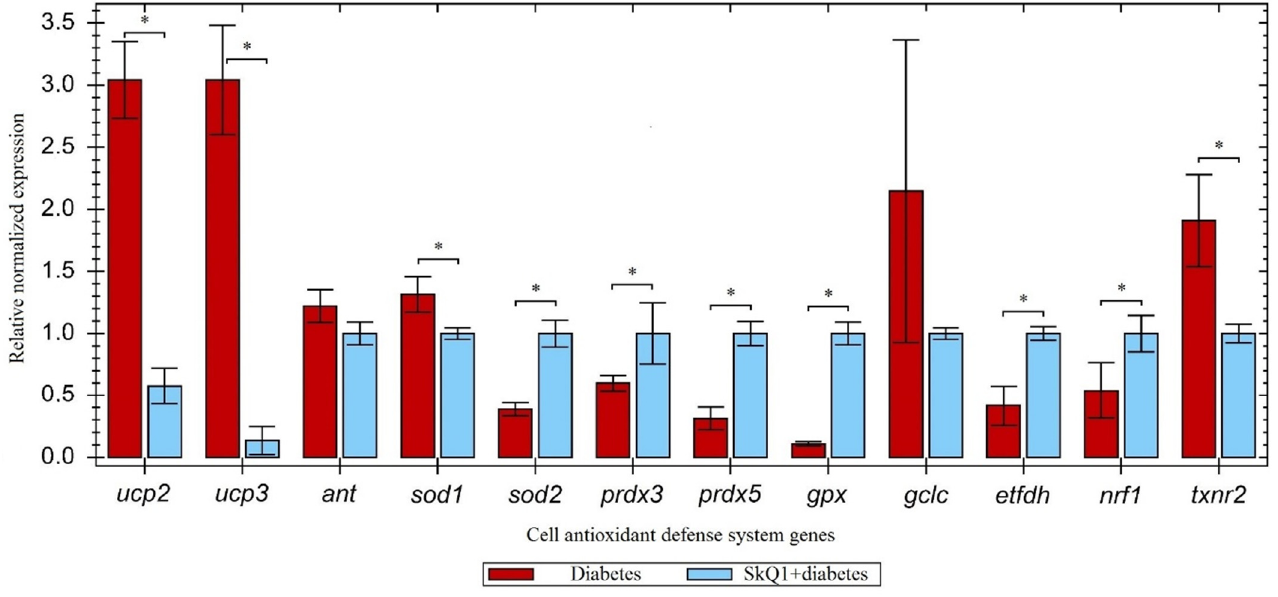
Figure 4. Efficiency of SkQ1 protective action against the background of developing type 1 diabetes mellitus (* p ≤ 0.05).